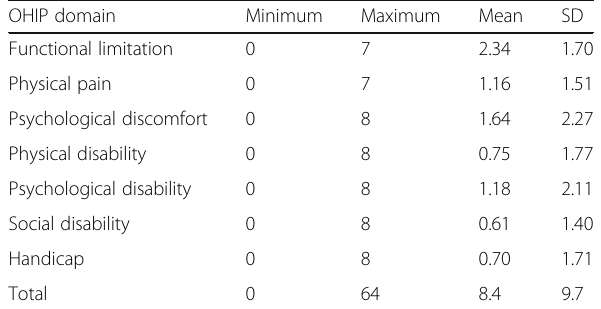
Table 5 Summary of OHIP-14 ( N = 44 and response range 0 –